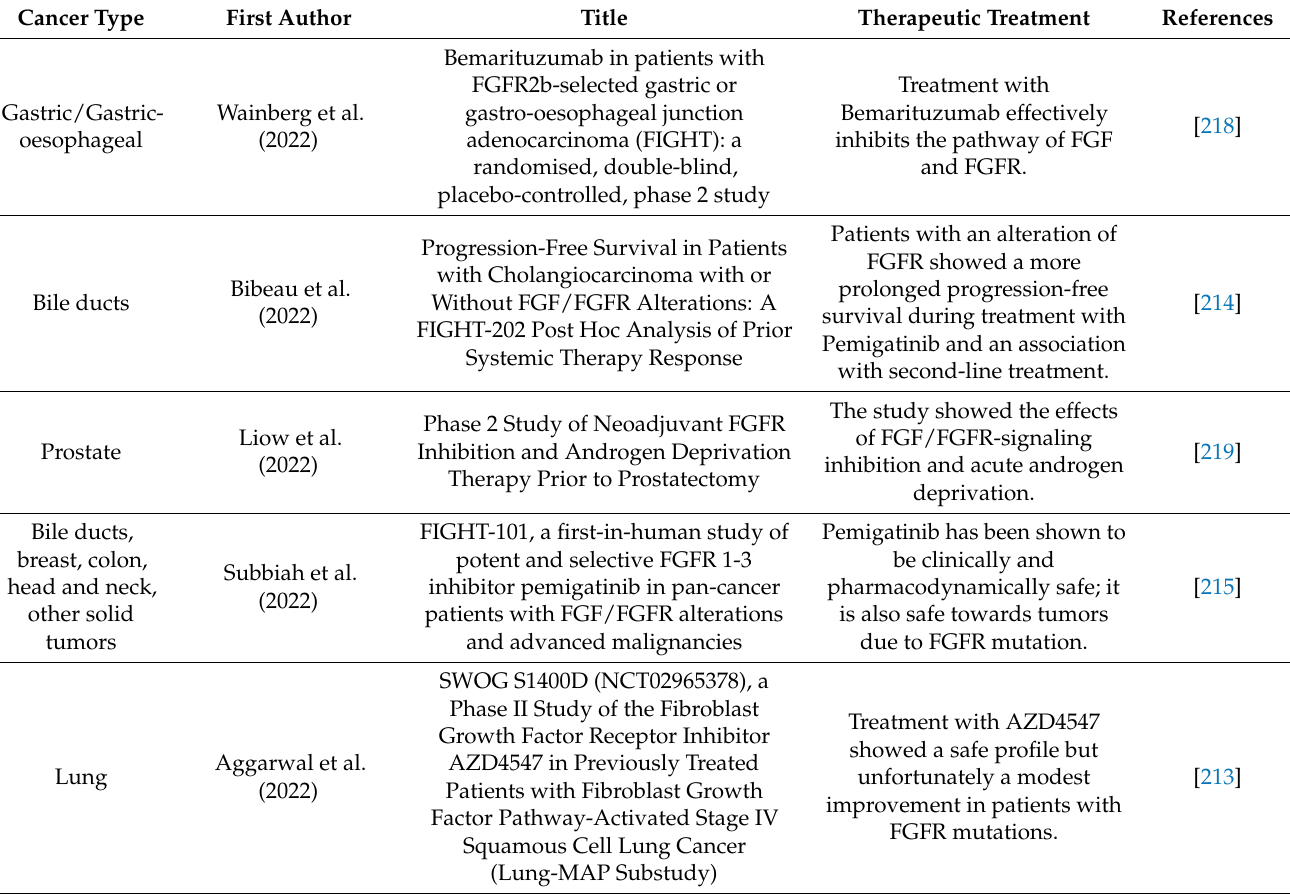
Table 2. Clinical trials evaluating new therapies against FGF/FGFR axis in different